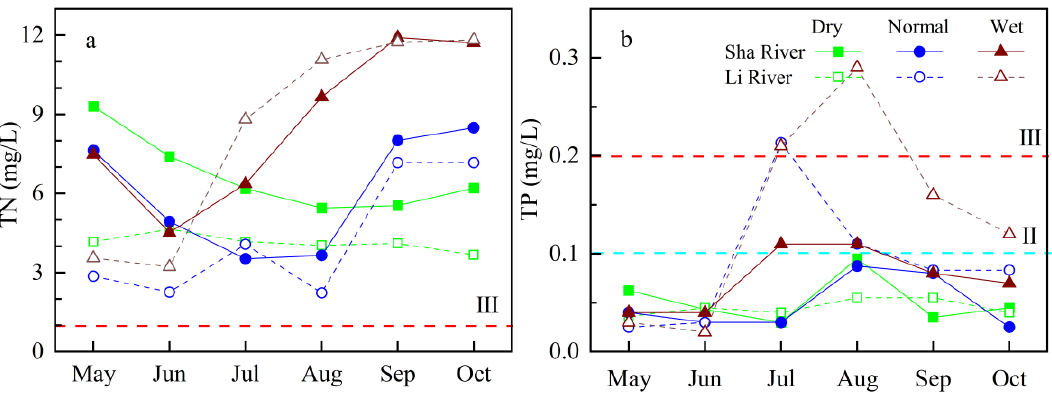
Figure 4. Monthly average TN ( a ) and TP ( b ) concentration changes of Sha River and Li River in high flow seasons from 2019 to 2021.The red and cyan dash line represented the Grade II (TP 0.1 mg/L) and III for surface water basing on the GB3838-2002.